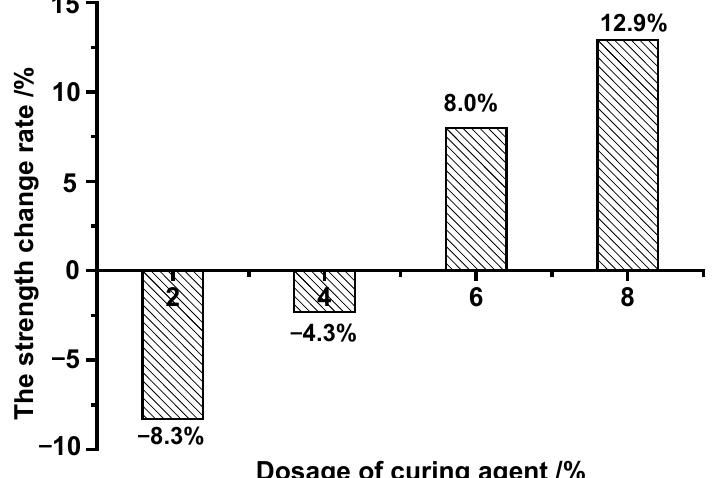
Figure 14. The strength change rate of the flexible curing agent stabilized silt.